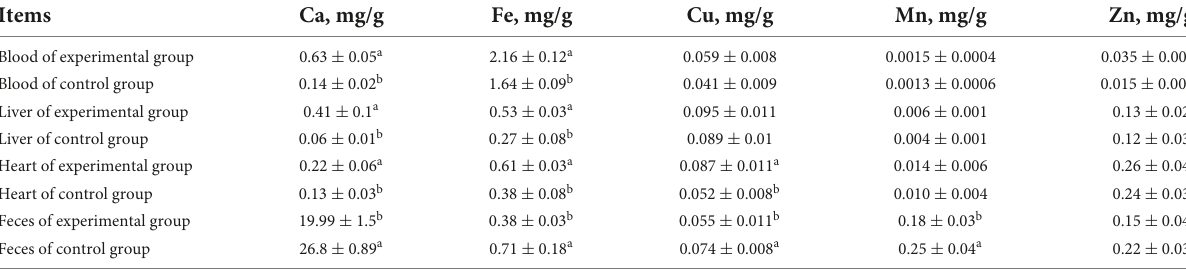
TABLE 6 Effect of MEFC on contents of mineral elements in blood, liver, heart and feces. Items